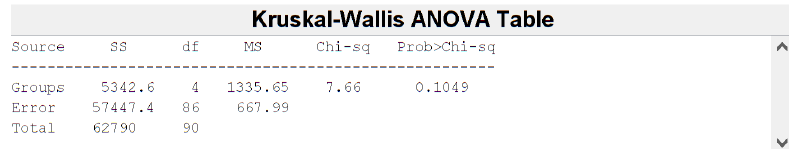
Figure 9. Kruskal-Wallis Table for the PC 1 scores. p -value = 0.6268 > 0.05.